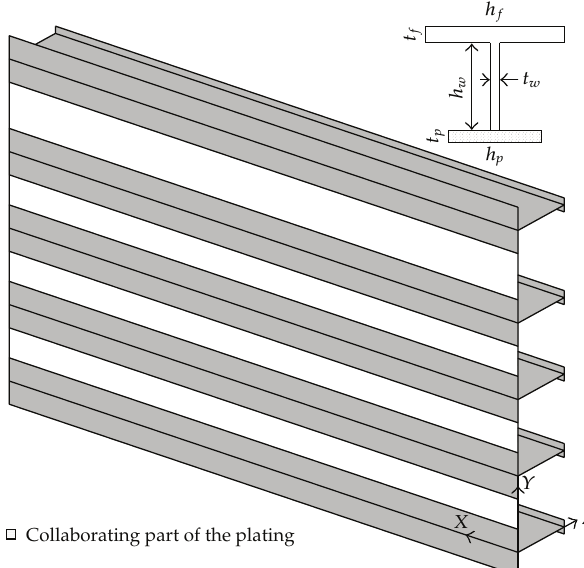
Figure 19: Mechanical model of the gate for assessing the resistance in the global deforming